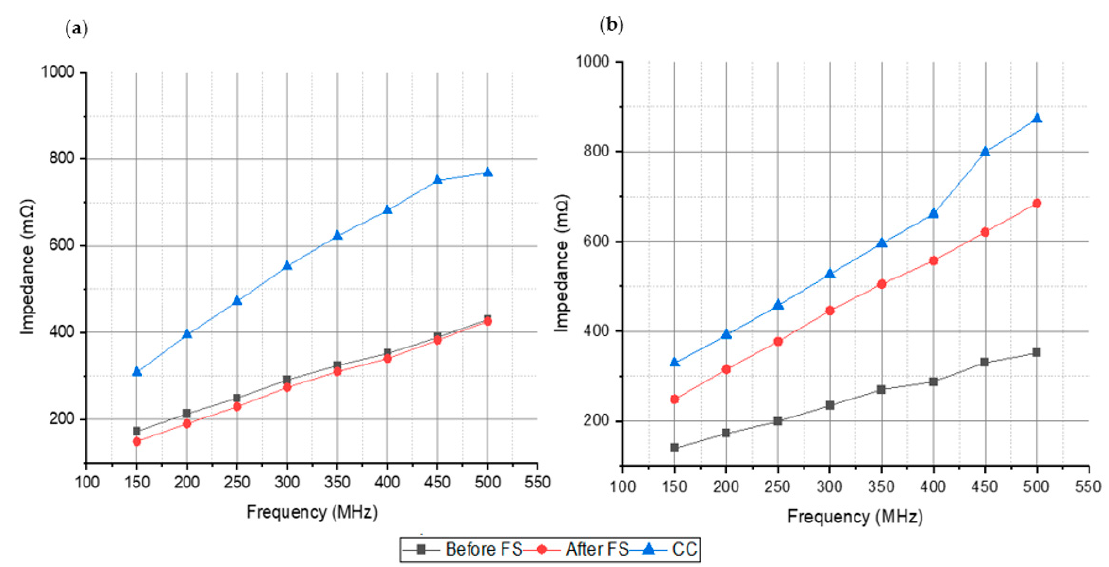
Figure 7. ( a ) Impedance values of discs with cell cultures (CC) vs previous impedance values before FS and after FS in fully dense sample. ( b ) impedance values in 30% porosity volume sample.